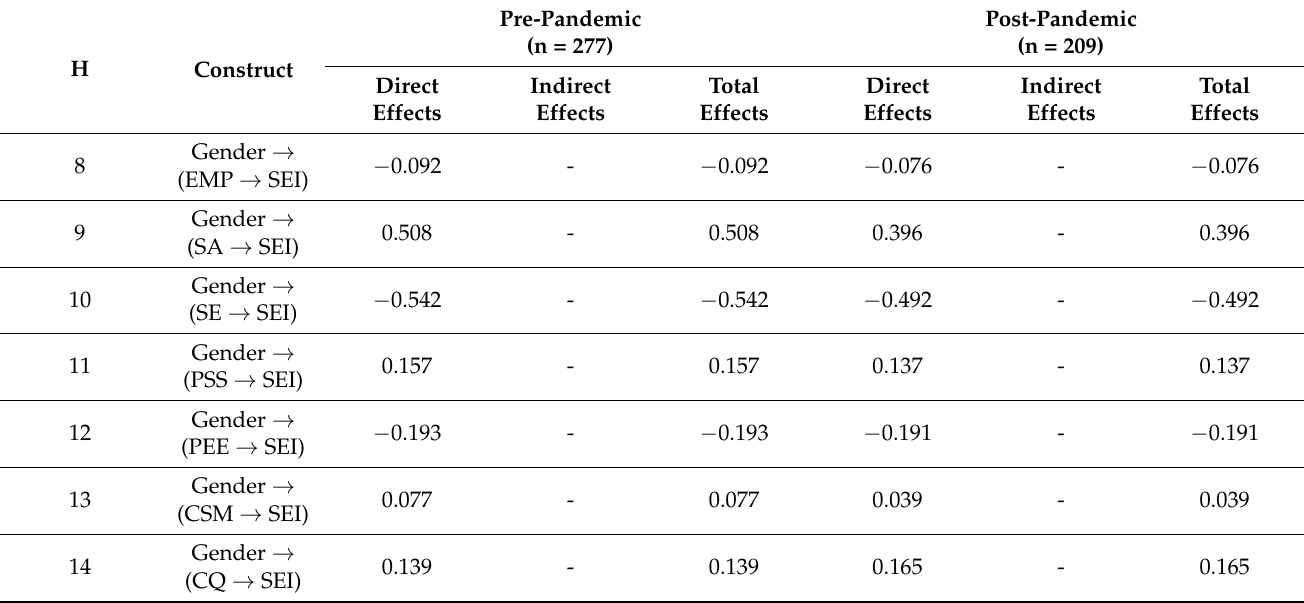
Table 9. Direct and total effects.